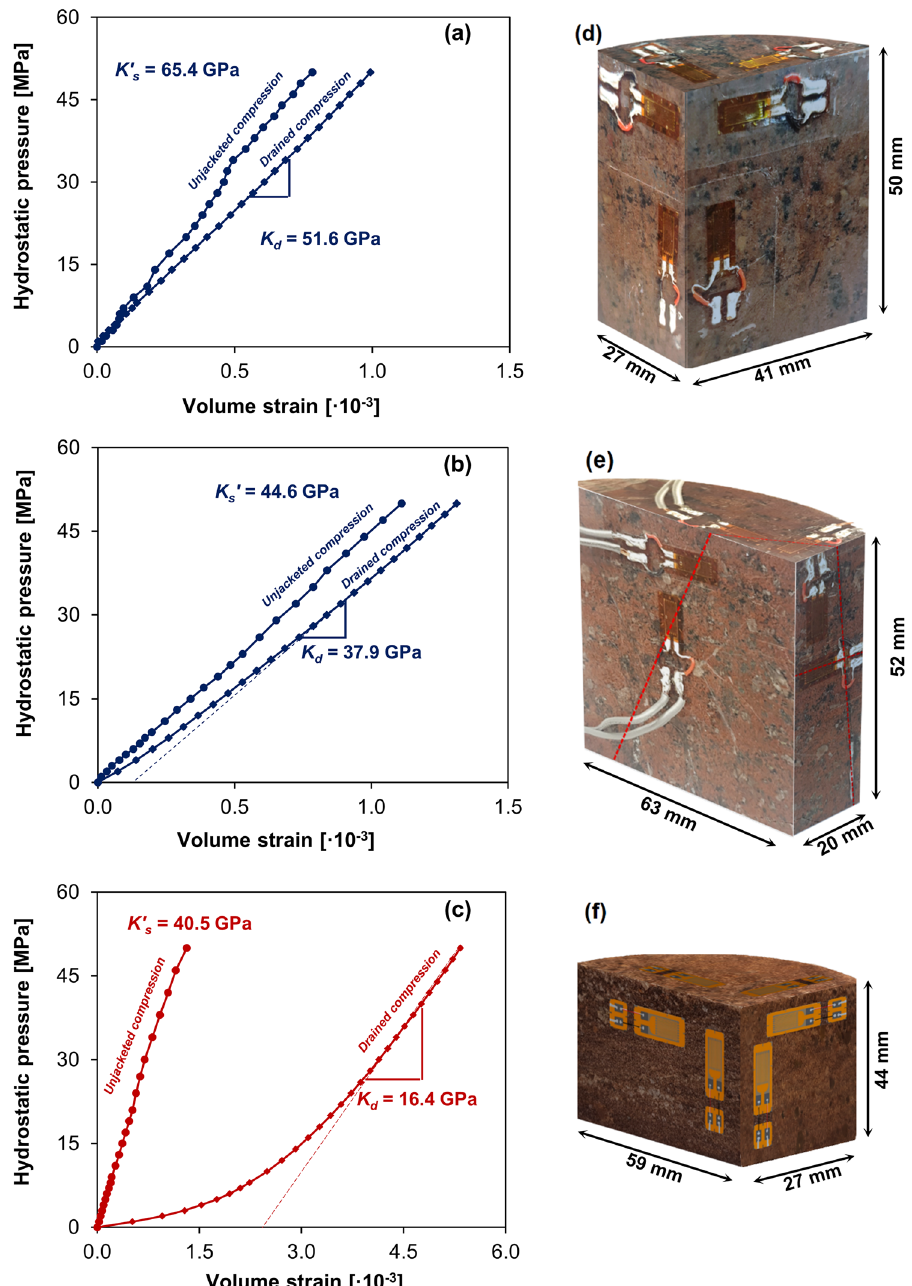
Figure 3. Hydrostatic pressure–volume strain diagrams from drained and unjacketed hydrostatic compression tests with ( a ) Intact Precambrian rhyolite 27 × 41 × 50 mm ( b ) Fractured Precambrian rhyolite 20 × 52 × 63 mm (fracture is highlighted with dashed line) ( c ) Argenta sandstone 27 × 44 × 59 mm. ( e , f ) Photographs of tested specimens with three orthogonal saw-cut